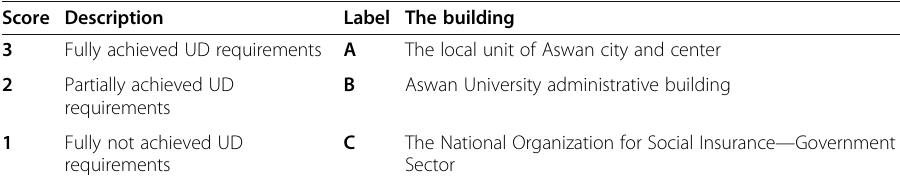
Table 2 The administrative building label and the score distribution of each item: Score